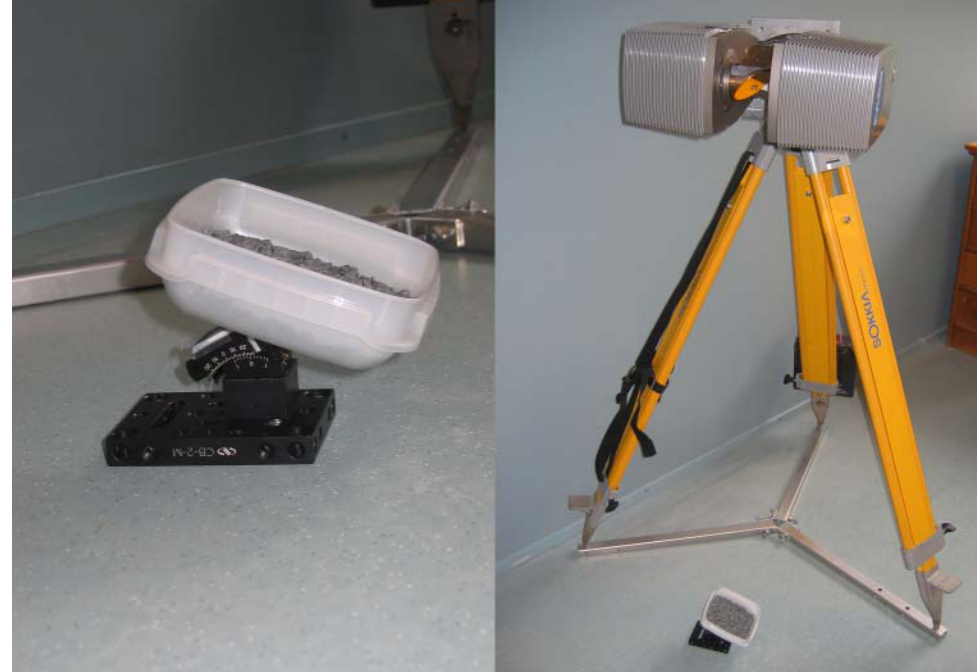
Figure 4. The Incidence angle experiment: The sample placed on a goniometer (left), which is tilted to change the angles of incidence (and emergence). The FARO scanner looking down to the sample